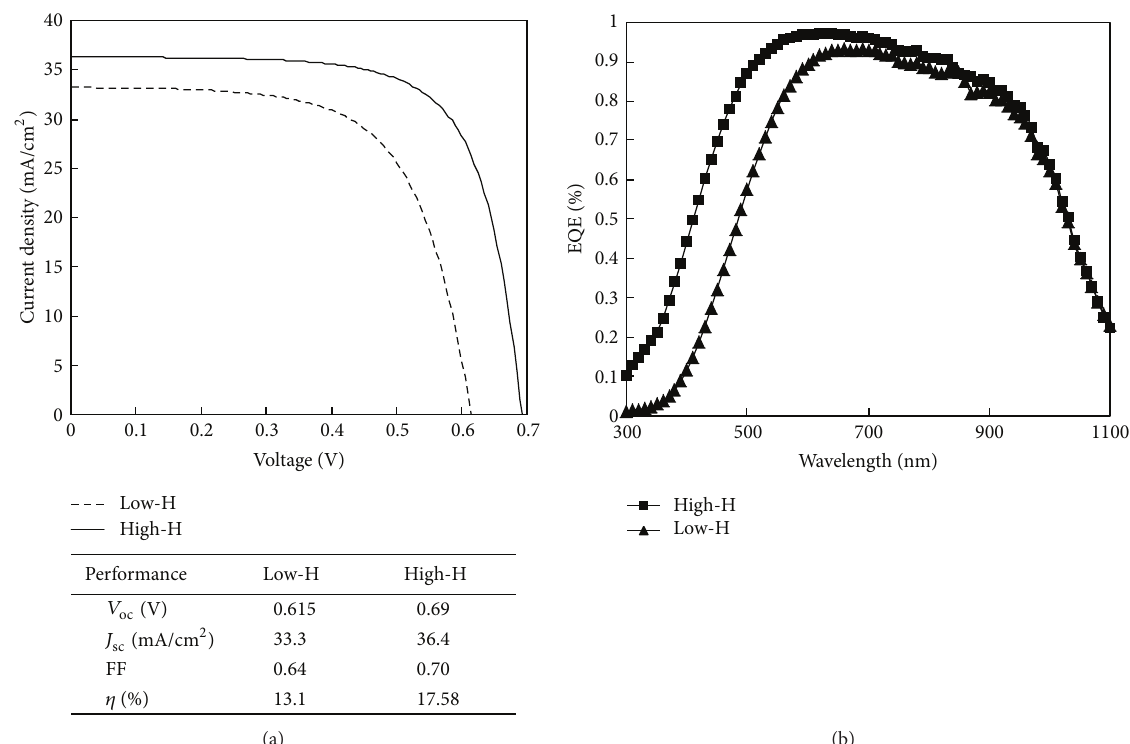
Figure 3: Experimental results of (a) J-V characteristics and (b) EQE spectra response for HJ solar cells with different i-layer hydrogen content.